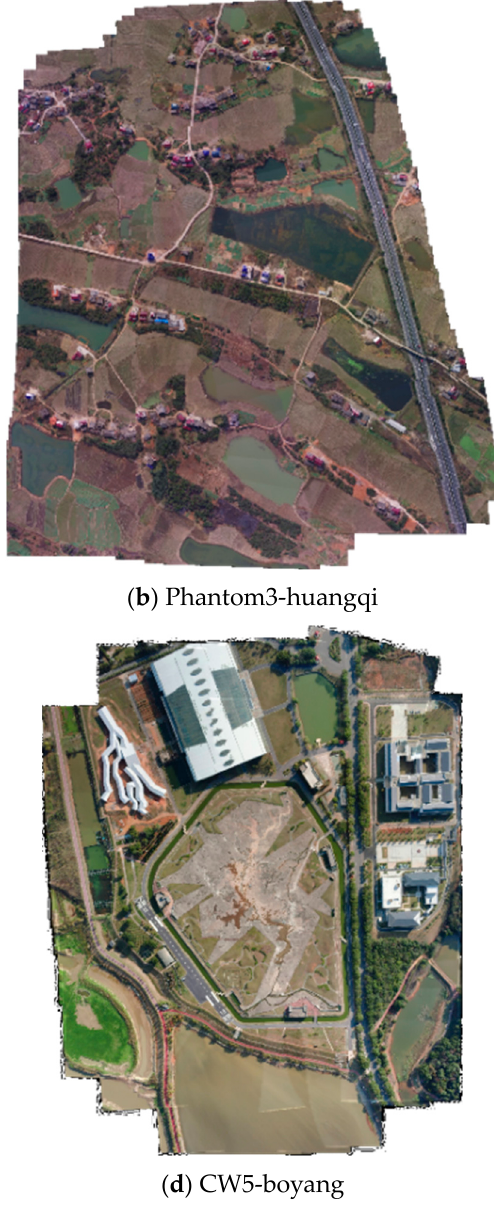
Figure 5. UAV image mosaicking result of the proposed system in real scenes. The sequences Phantom3-village, Phantom3-huangqi, and Phantom3-factory are from the NPU drone map dataset and CW5-boyang is collected by us.